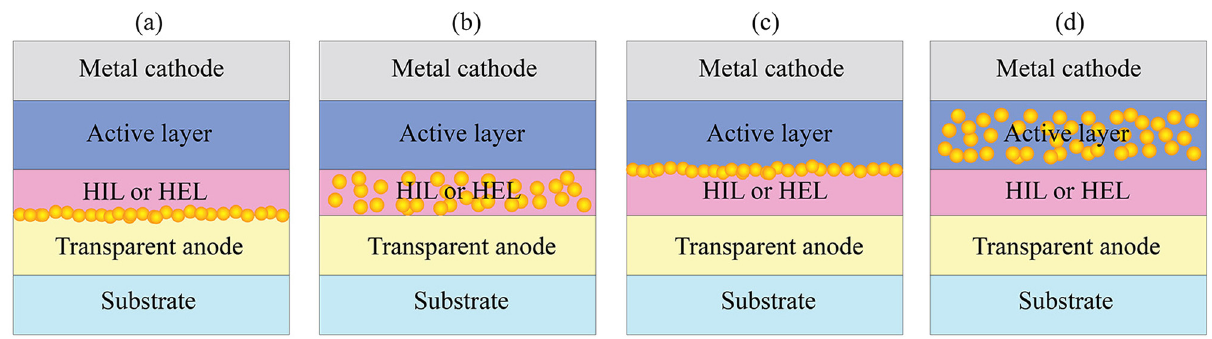
Figure 3: Schematic diagram of device structure with NP in OLEDs and OPVs, ( a ) between anode and hole injection or extraction layer ( ITO/ HIL or HEL ) , ( b ) in HIL or HEL ( main focus in this review ) , ( c ) between active layer and HIL or HEL, and ( d ) in active layer.